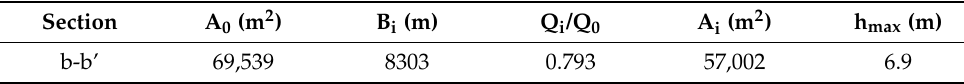
Table 1. Equilibrium water depth of the North Passage before the project.